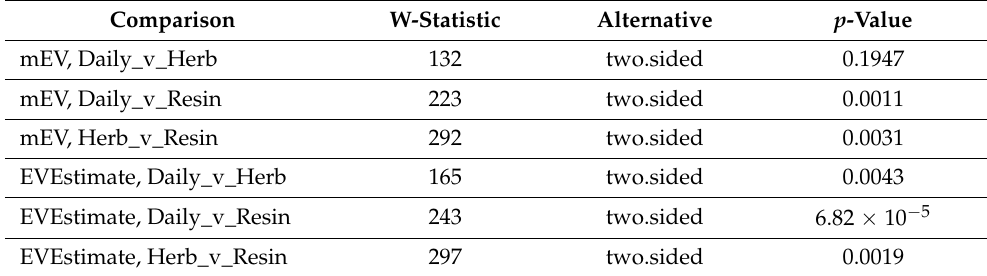
Table 15. Wilcoxson Tests of Major Group